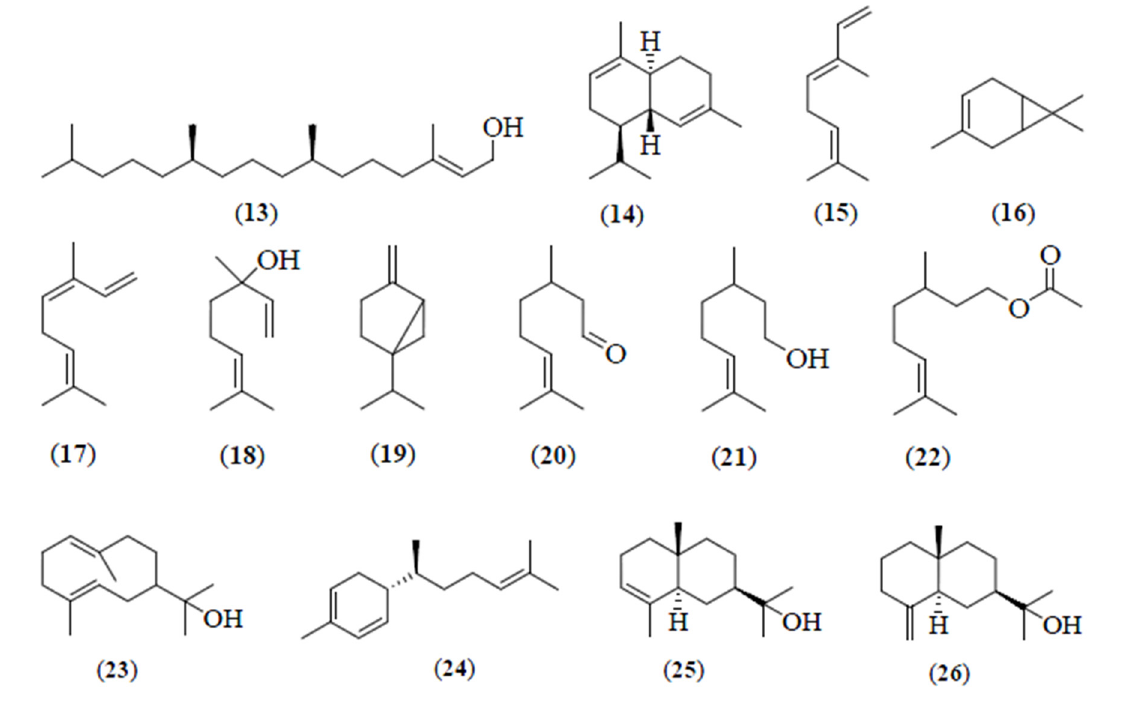
Figure 3. C hemical structures of the components identified from the Citrus essential oils. Figure 2. Chemical structures of the components identified from the Citrus essential oils.